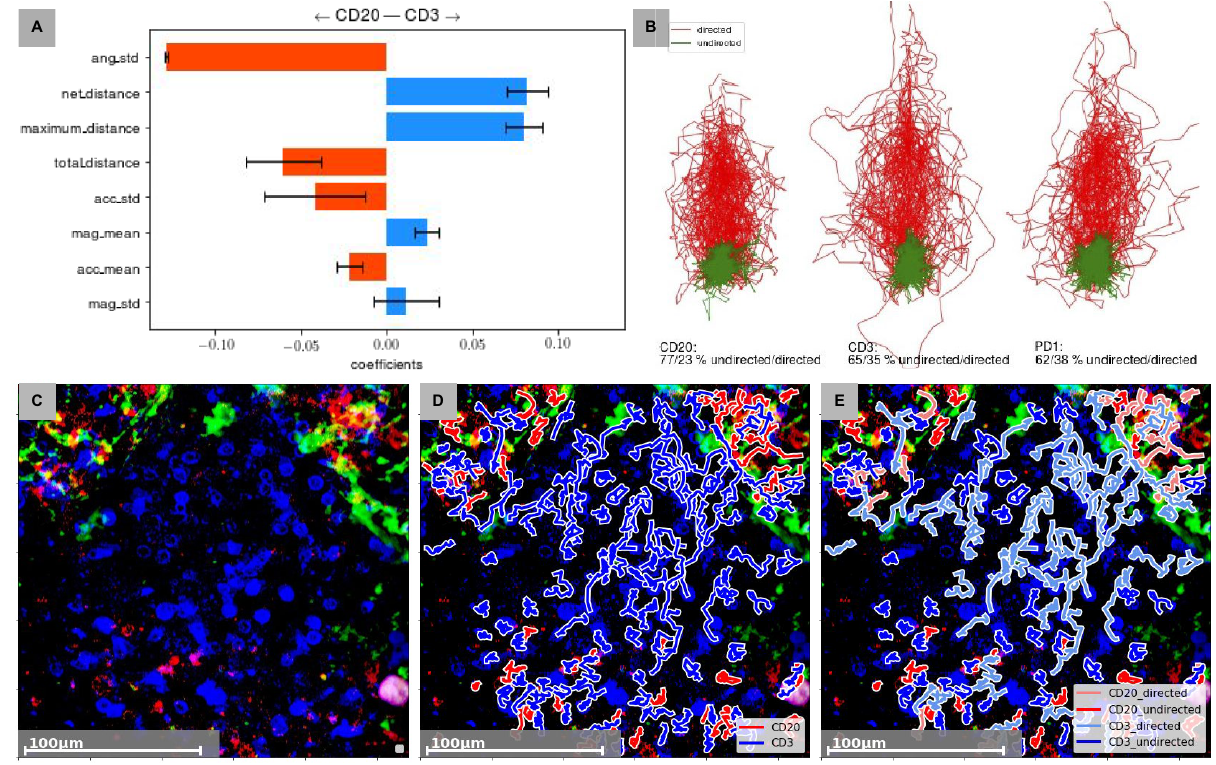
Figure 4. The definition of motion-specific subsets of cell types. The so called data-driven clusters (DD-cluster), directed and undirected, are based on eight most discriminative features derived from binary logistic regression experiment CD20 vs CD3, shown in ( A ). ( B ) displays the composition of DD-clusters per cell type, defined by unsupervised machine learning. Conclusively, ( C – E ) visualize the data enrichment based on movement and machine learning. ( C ) shows information given by conventional immunohistochemistry. ( D ) visualizes the information given by immunohistochemistry enriched with movement and computer vision. ( E ) visualizes information facilitating immunohistochemistry, movement, computer vision and machine